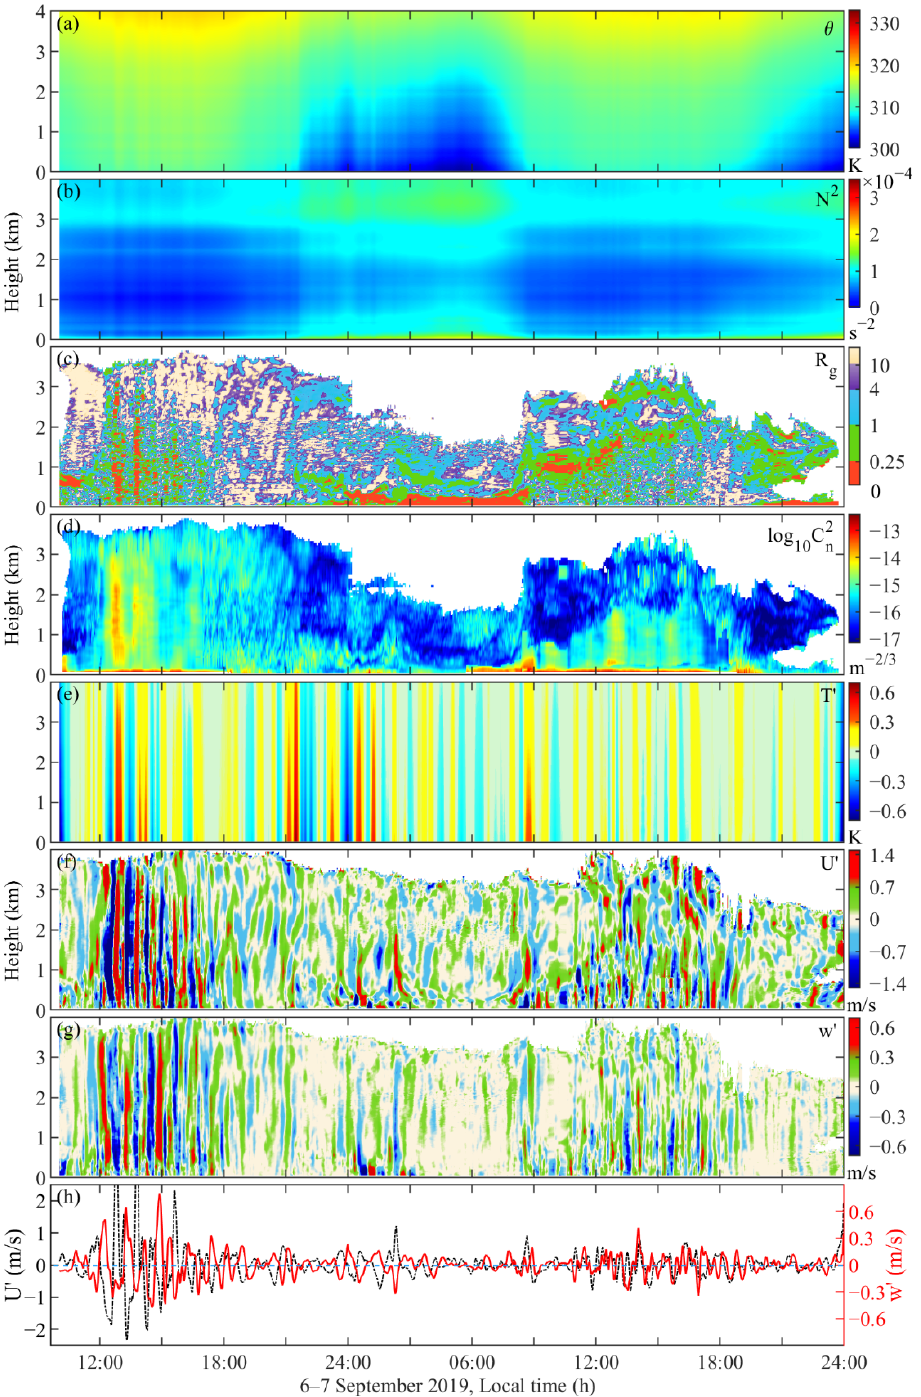
Figure 6. The potential temperature ( a ), Brunt–Väisälä frequency squared ( b ), gradient Richardson number ( c ), log 10 C 2 n ( d ) profiles, perturbations of temperature ( e ), horizontal wind speed ( f ), vertical wind speed ( g ), and averaged wind speed perturbations within 1–2 km ( h ) derived from CDWL and MWR in the observations on 6–7 September 2019, local time.